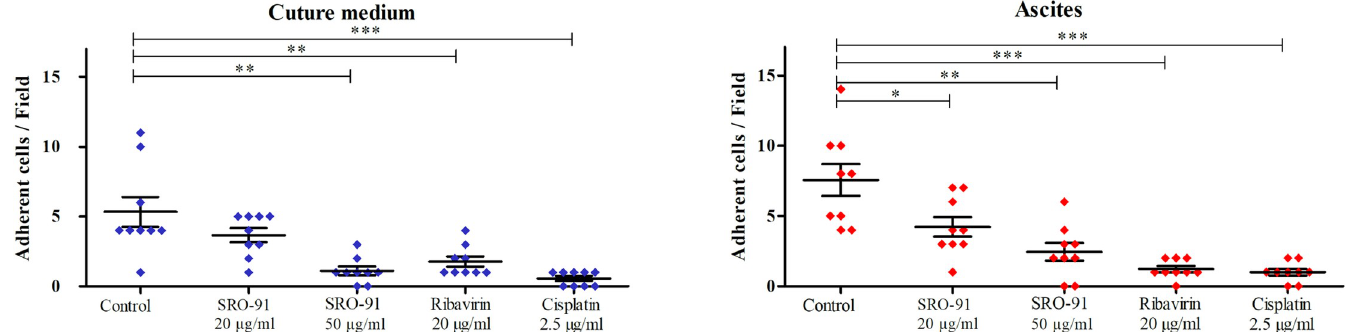
Fig 12. Implantation of cancer cells into the peritoneal mesothelium after SRO-91 or ribavirin treatment. Co-cultures of mesothelial cells grown as monolayer and DiI-labeled tumor cells were observed using a Nomarski filter to ensure mesothelial integrity. Cancer cell adhesion to the mesothelial monolayer was determined by counting fluorescent cells on the underlying non-fluorescent mesothelial cells with the software ImageJ 1 . P-values were calculated by the unpaired t-test was performed ( ��� P < 0.001, �� P < 0.01, � P < 0.05).